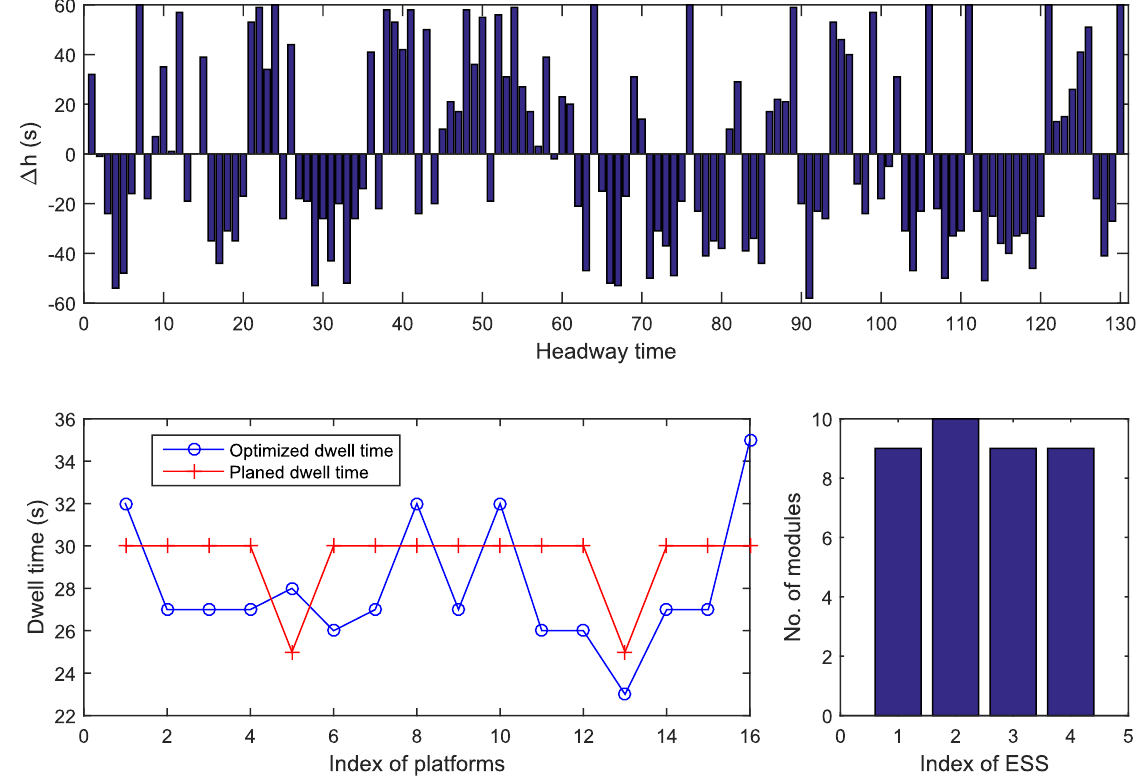
Figure 8. One optimized timetable and WESS